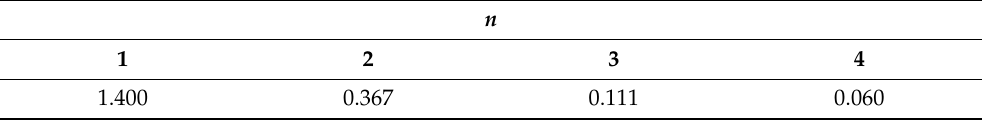
Table 9. Crowd reduction factors C δ ( n )